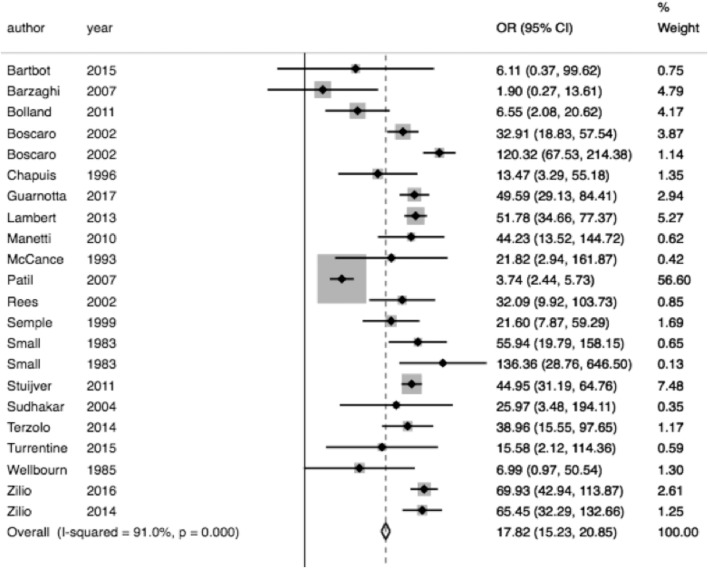
Increase odds of VTE in CS. Total OR 17.82 (95% CI 15.24–20.85) of VTE in CS compared to general population when unadjusting for VTE within 30 days of an operation. However, the interpretability of this analysis is limited by the degree of heterogeneity of odds ratios between studies included, as indicated by the I2 statistic of 91.0%.